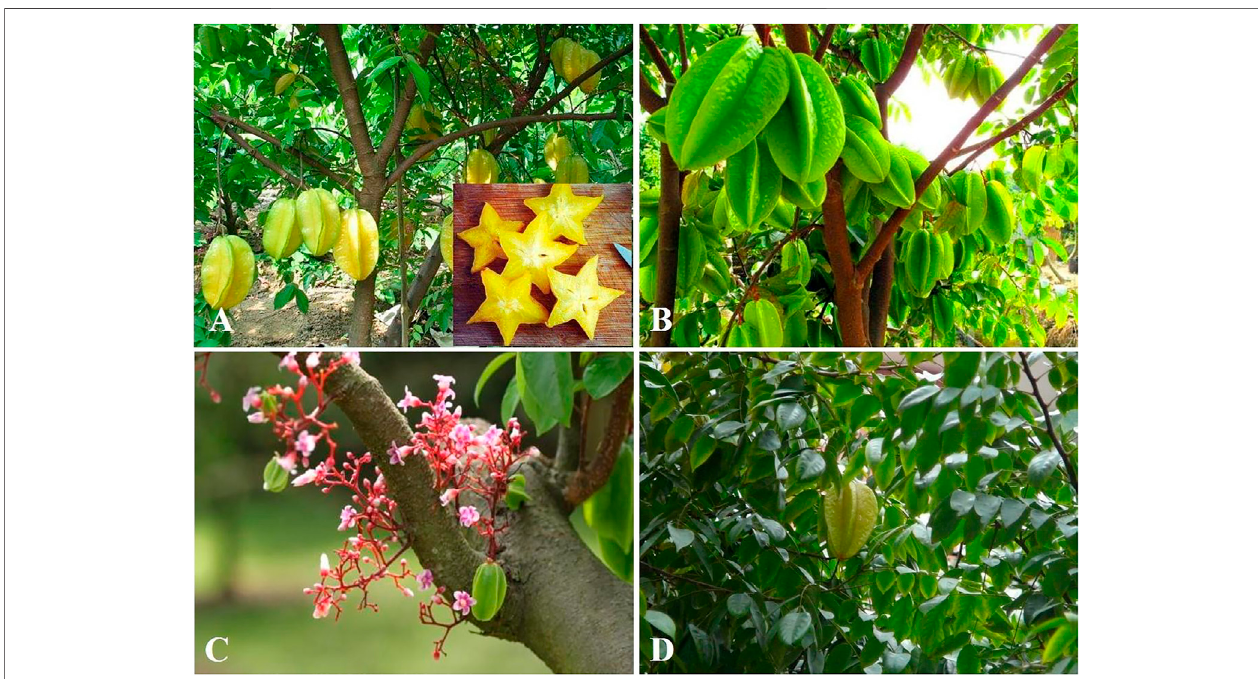
FIGURE 1 | A. carambola : (A) : whole plants; (B) : fruits; (C) : fl owers and woods; (D) : leaves (https://image.baidu.com/).